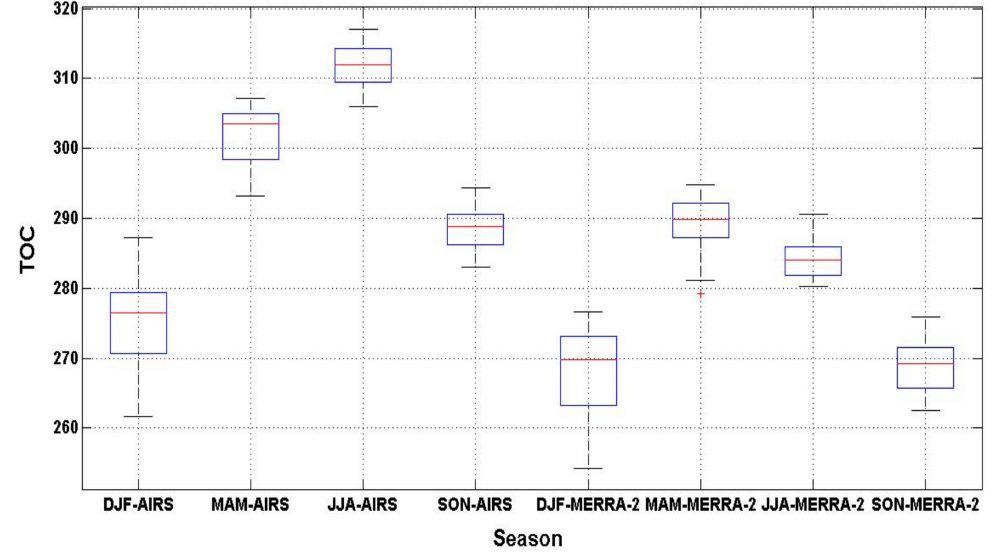
Figure 5. Boxplot seasonal monthly average of TOC (2005–2016) from AIRS and